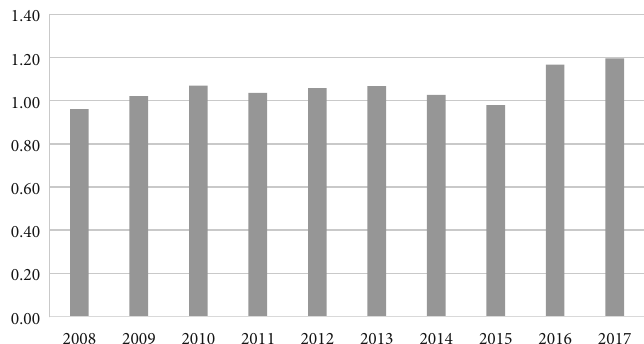
Figure 1. Environmental efficiency in China from 2008 to 2017 (source: National Bureau of Statistics of China,